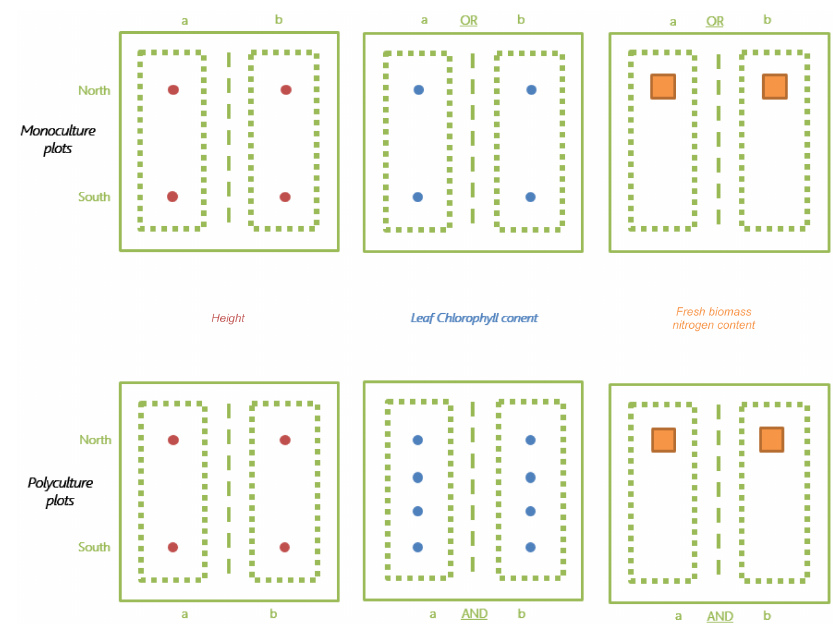
Figure 2. Schematic overview of individual plots and the approximated location at which samples for plant traits were collected.